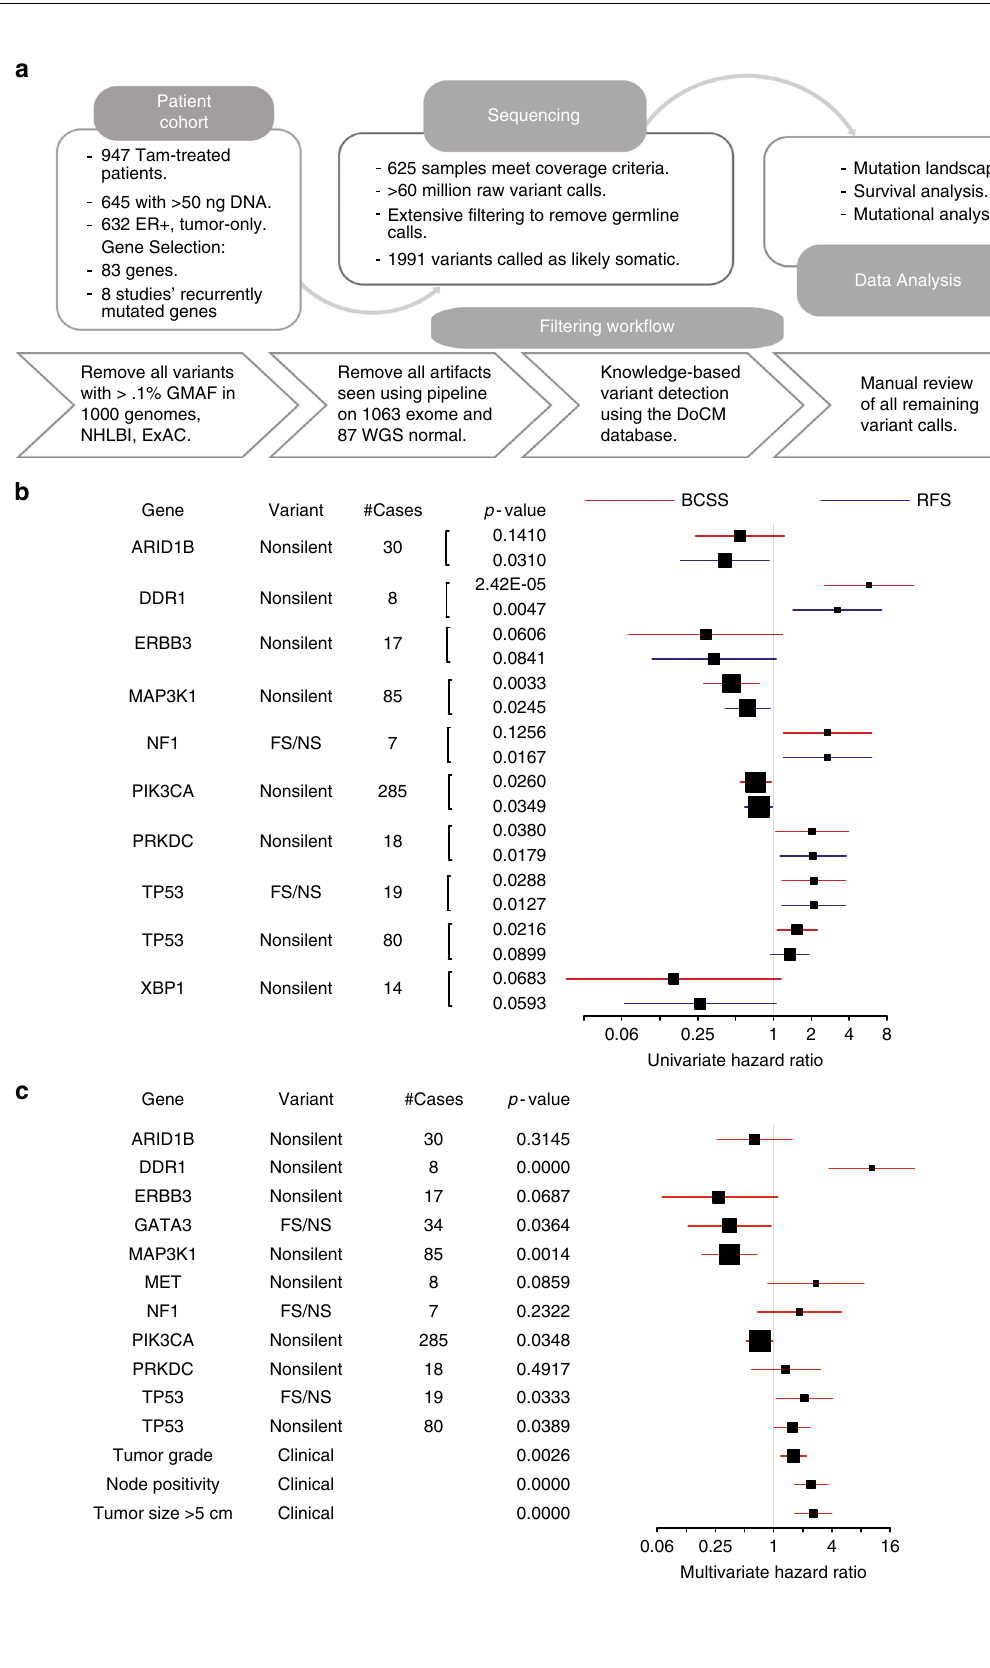
NATURE COMMUNICATIONS| (2018) 9:4850 |DOI: